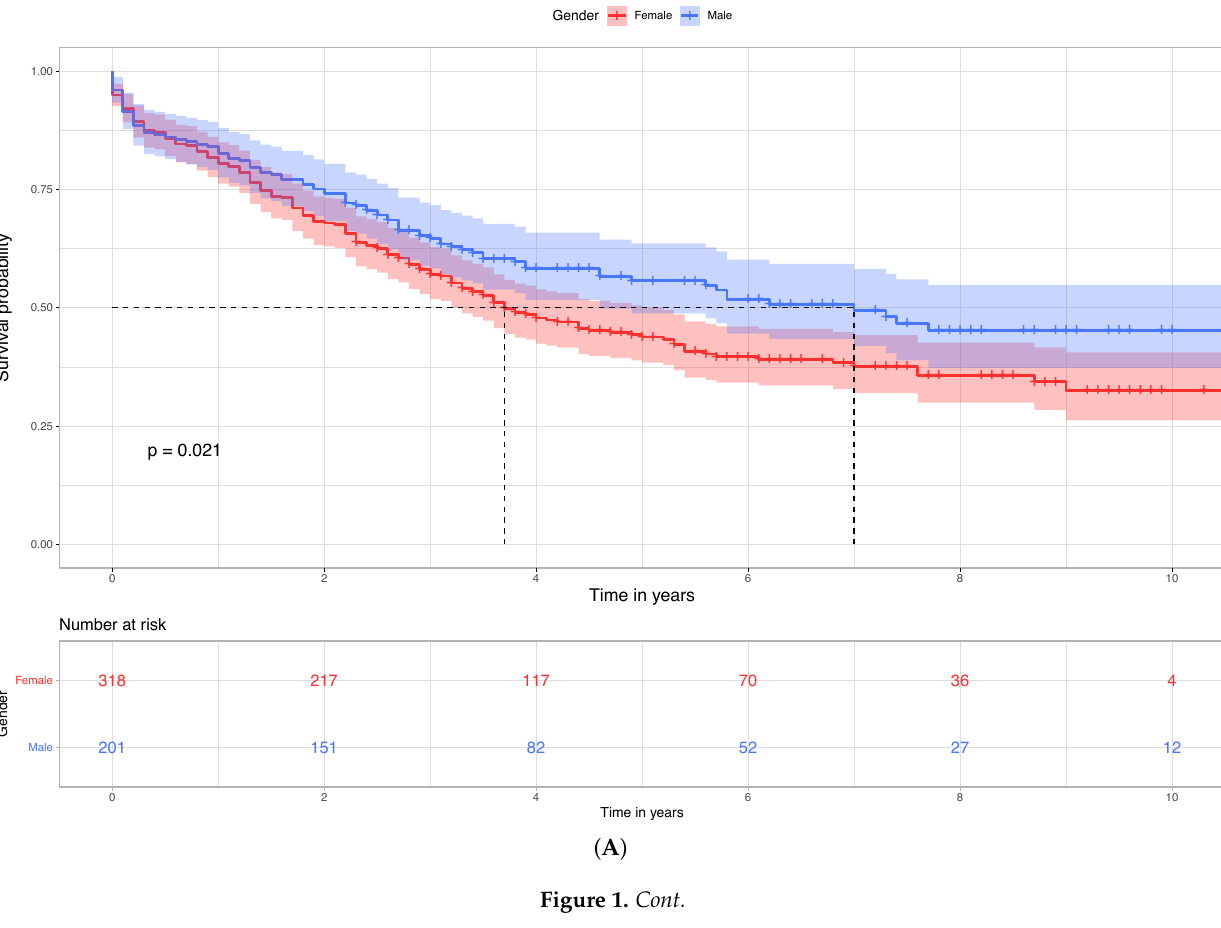
Figure 7. Sampled estimated trajectories by ( a ) EKF, ( b ) SEKF and ( c ) SEKF 2 based on the four RFID tags reported in the figure with star markers.